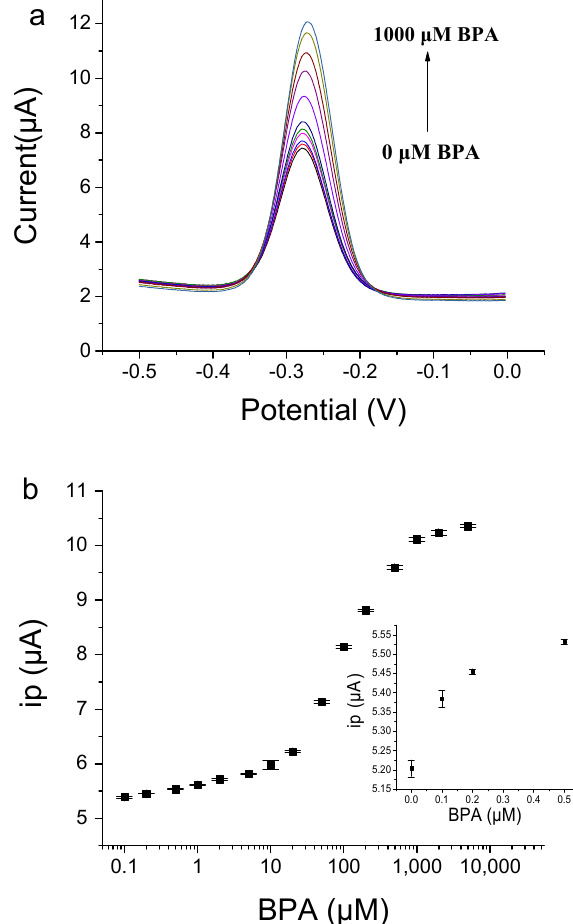
Figure 7. The aptamer-based electrochemical sensor for BPA detection by using BP29-3’-MB modified electrode. ( a ) SWV signals of various concentrations of BPA. ( b ) Plot of peak current responses towards BPA concentration. The inset shows the peak current responses to low concentrations of BPA and blank samples.